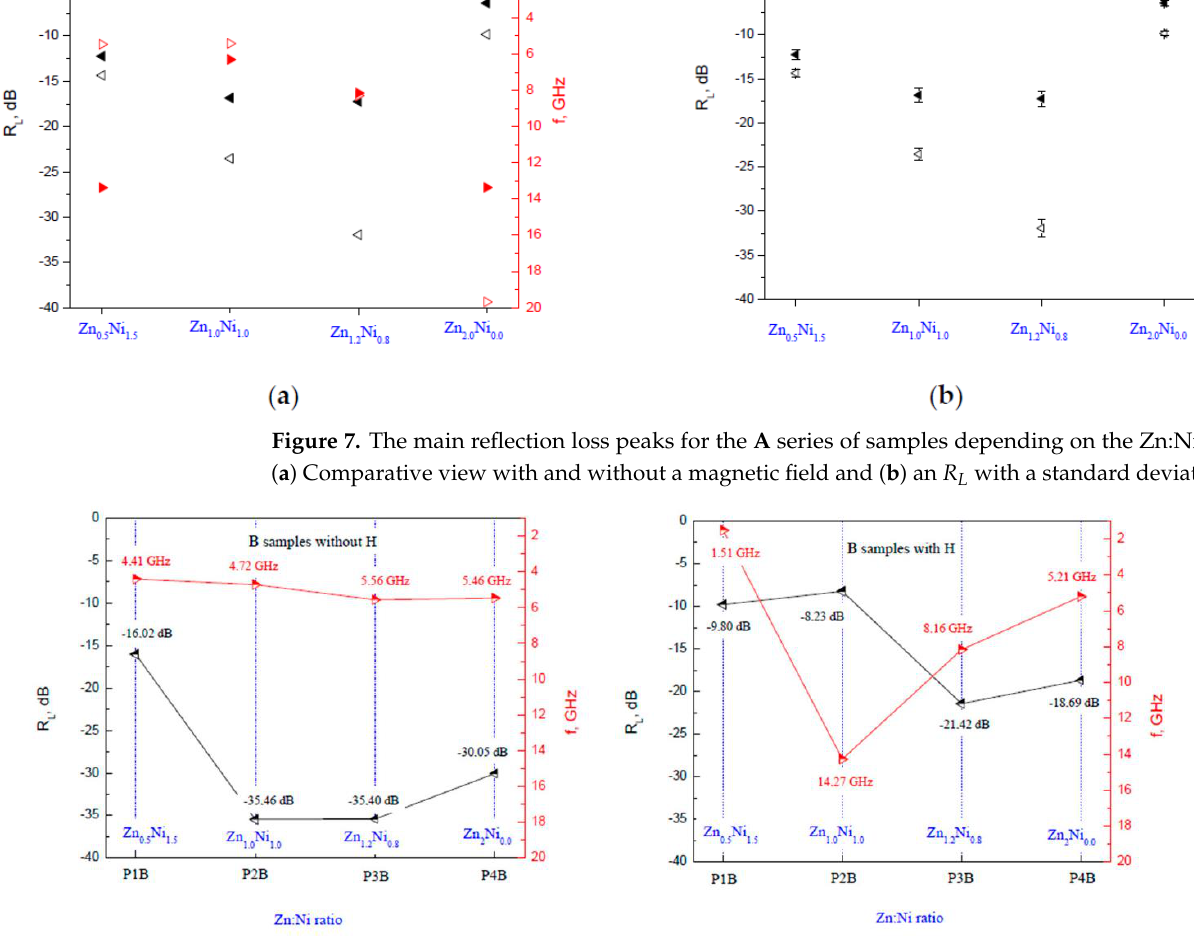
Figure 8. The main reflection loss peaks for the B series of samples depending on the Zn:Ni ratio ( a )